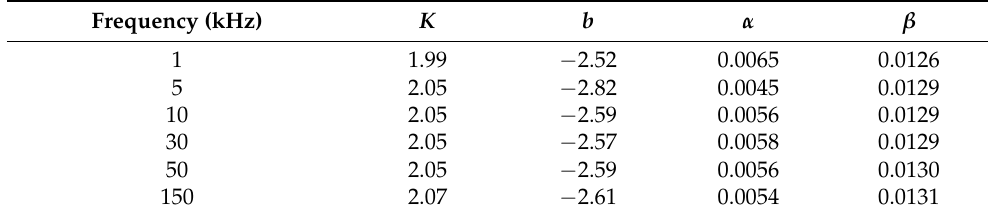
Figure 9. Fitting curve of AE signal energy attenuation of T1 specimen. ( a ) Pulse frequency 1 kHz; ( b ) Pulse frequency 10 kHz; ( c ) Pulse frequency 30 kHz; ( d ) Pulse frequency 50 kHz; ( e ) Pulse frequency 150 kHz. Table 3. Fitting parameters of AE signal energy attenuation of T1